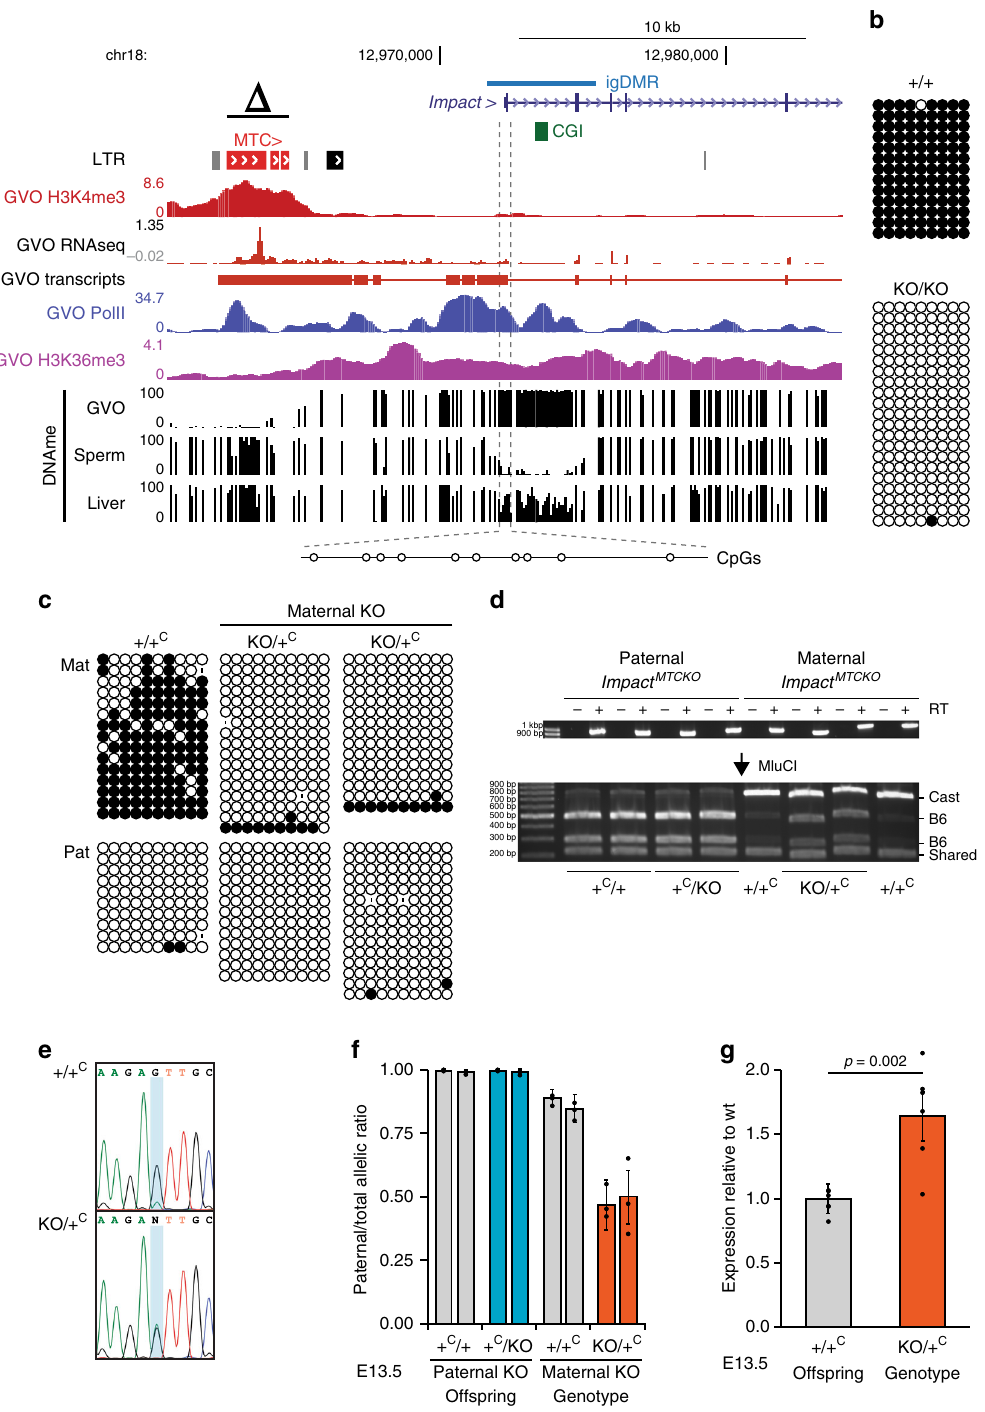
Fig. 6 Loss of imprinting at Impact upon maternal transmission of the MTC KO allele. a Genome-browser screenshot of the mouse Impact locus, including the upstream MTC LTR (red), CGI (green), and igDMR (blue). GVO RNA-seq as well as RNA pol II, H3K4me3, and H3K36me3 ChIP-seq tracks are shown, along with DNAme data for GVO, sperm, and adult liver. The region within the igDMR analyzed by sodium bisul fi te sequencing (SBS), which includes 10 CpG sites, is shown at the bottom. Δ : extent of the upstream MTCKO deletion allele. b DNAme of the Impact igDMR in GVO from wild-type and Impact MTCKO/MTCKO females determined by SBS. c DNAme of the Impact igDMR in E13.5 ( Impact + /MTCKO × CAST)F1 embryos determined by SBS. Data for control ( + / + C ) and heterozygous (KO/ + C ) littermates with a maternally inherited MTCKO are shown. + C : wild-type CAST allele; KO: Impact MTCKO . A polymorphic insertion and a SNP in the ampli fi ed region allow for discrimination of maternal (Mat) and paternal (Pat) strands. d, e Allele-speci fi c expression analysis of F1 E13.5 embryonic head RNA by d RT-PCR followed by MluCI RFLP analysis, and e Sanger sequencing of a A ⟷ G transition in the 3 ′ UTR of the Impact mRNA (maternal B6: A allele; and paternal CAST: G allele). RT: reverse transcriptase. Source data are provided as a Source Data fi le. f Quanti fi cation of relative levels of expression from the paternal Impact allele based on the analysis of embryos as in e . Graph shows mean ± S.D of three SNPs. Source data are provided as a Source Data fi le. g Impact mRNA levels analyzed by RT-qPCR on E13.5 embryonic RNA ( n = 6 biologically independent samples). Expression levels are relative to those for the wild-type allele. Graph shows mean ± S.E.M. Source data are provided as a Source Data fi